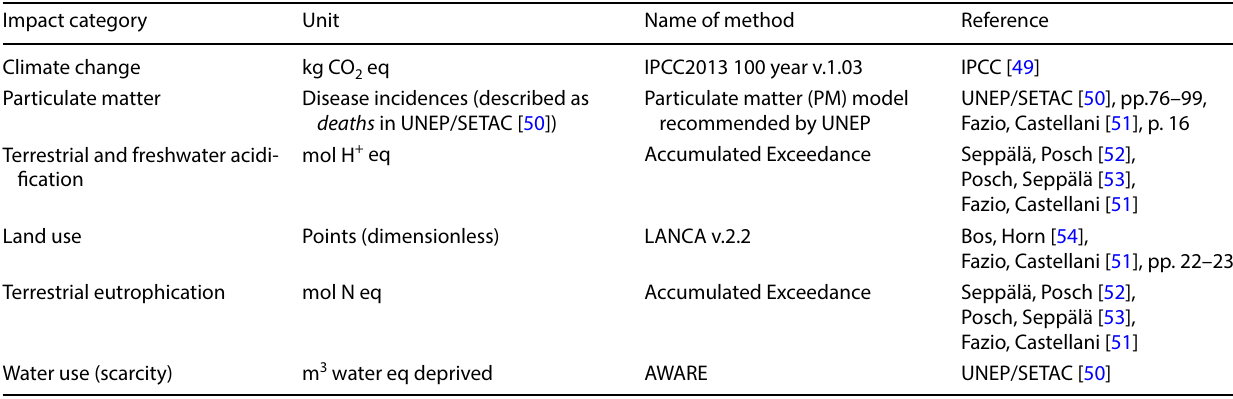
Table 2 Environmental impact categories